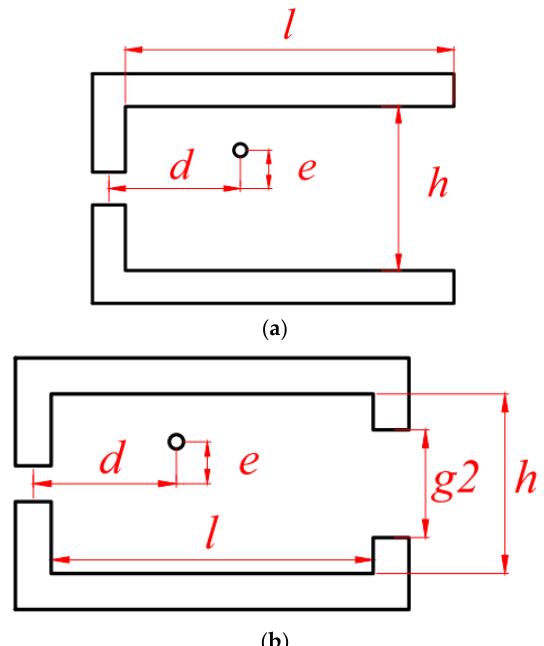
Figure 6. Parameters subject to variation for the two constructions: ( a ) construction with one air gap; ( b ) construction with two air gaps.